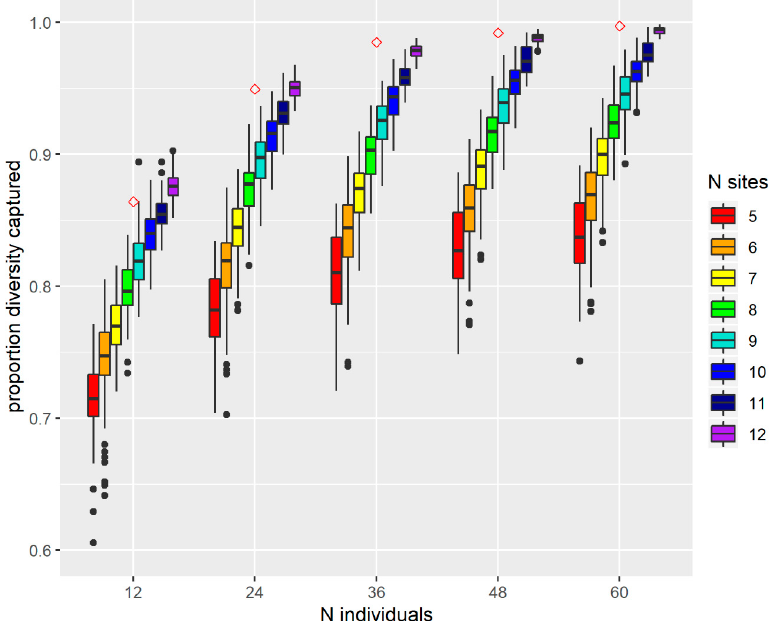
Figure 3. The proportion of genetic diversity captured, from that available amongst the genotyped samples, through different collecting strategies with different sample sizes (X-axis) and from a different number of randomly selected sites for A . purpureopetala . With a resulting sampling size of 24 individuals, sampling individuals from 12 sites captured significantly more diversity than from five sites (93 to 96% diversity vs 72 to 83%, p < 0.001). Sites were selected randomly from all available sites and individuals selected randomly from available individuals. Each box whisker plot summarises the sampling event across 100 randomisations. The red open diamond represents the “benchmark” of diversity to be captured across the entire dataset with each specified sample size.